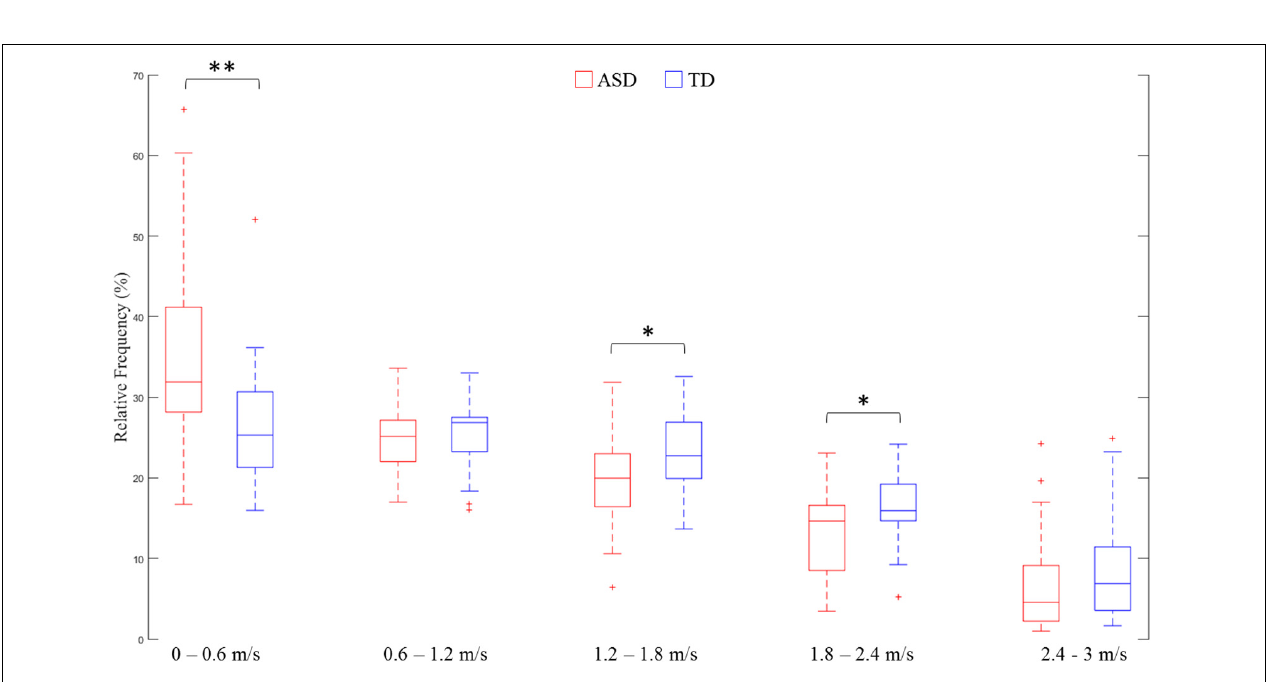
FIGURE 4 | Comparison of velocity distribution in each absolute velocity segment. ∗∗ means p < 0.01; ∗ means p < 0.05.